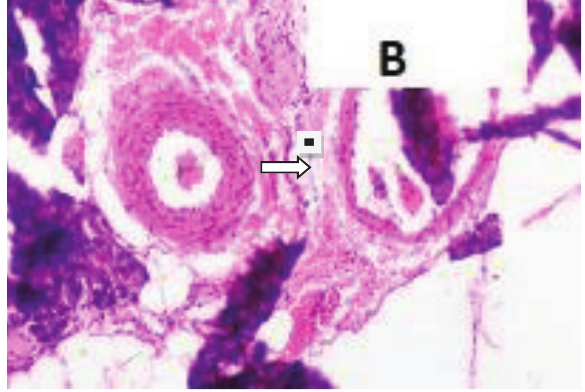
Fig-6: Group B (positive control) Severe reduction in the size and number of islets in STZ-induced diabetic rat (40 x; H&E)